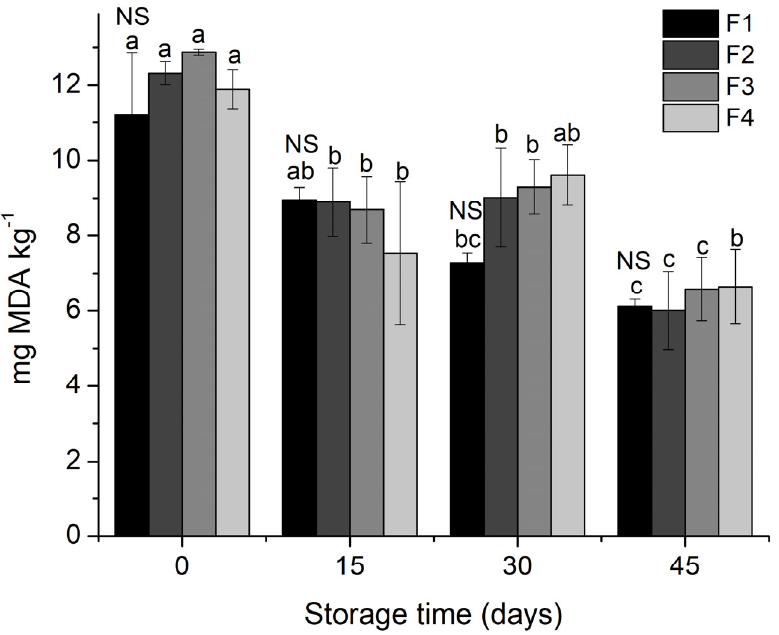
Figure 2. Average values of TBARS (mg of MDA Kg − 1 ) in starch biscuit formulation during storage time. MDA: malonaldehyde; F1: starch biscuit control (no added antioxidant); F2: starch biscuit with butylated hydroxytoluene (BHT); F3: starch biscuit added microencapsulated propolis co-product (MECP); F4: starch biscuit added lyophilized propolis co-product (LFCP). NS: there are no statistical differences ( p > 0.05) by the Tukey test between the formulations in the respective storage time. Different lower-case letters above the formulation column represent statistical differences ( p < 0.05)